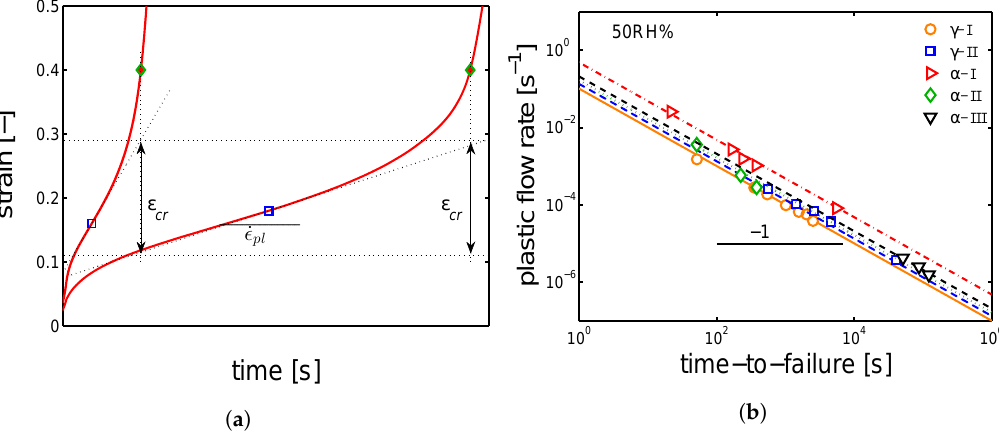
Figure 18. ( a ) examples of creep tests at constant applied load, the scheme shows the definition of ˙ (cid:101) pl , (cid:101) cr and t f ; ( b ) plastic flow rates as functions of time-to-failure for samples conditioned at RH 50% and 23